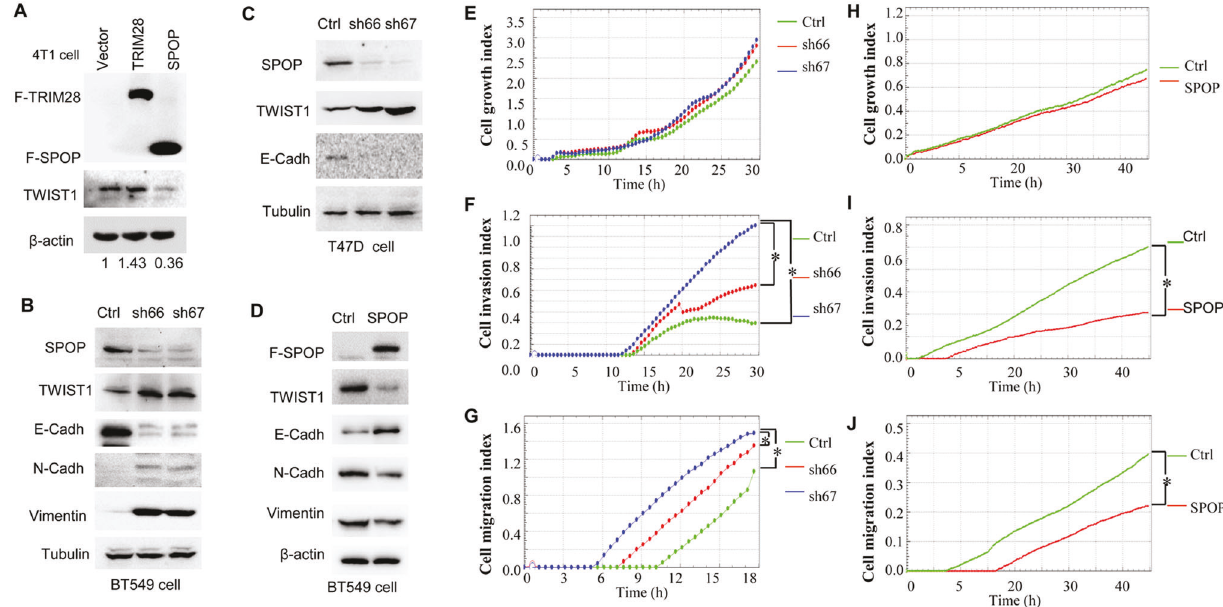
Fig. 2 Knock-down of SPOP up-regulates TWIST1 and promotes breast cancer EMT, cell migration and invasion, whereas up-regulated SPOP suppresses EMT. A Over-expressed SPOP decreases TWIST1 protein levels. B Knock-down of SPOP up-regulates TWIST1 and facilitates expression of epithelial markers N-cadherin and Vimentin, and also downregulates mesenchymal marker E-cadherin in breast cancer cell BT549. Cells transfected with shCtrl or shSPOP (sh66 and sh67) vectors and protein lysates were collected at the indicated times for western blotting. C Knock-down of SPOP up-regulates TWIST1 and down-regulation of mesenchymal marker E-cadherin in breast cancer cell T47D. There is no detectable N-cadherin and Vimentin in T47D. D Over-expressed SPOP decreases TWIST1 protein levels and inhibits epithelial markers N-cadherin and Vimentin, and upregulates mesenchymal marker E-cadherin in breast cancer cell BT549. E – G Roles for cell index, cell migration and invasion by knock-down of SPOP in BT549 cell line. H – J Roles for cell index, cell migration and invasion by overexpression of SPOP in BT549 cell line. Real-time cell growth index, migration and invasion assays were performed in a real time cell analyzerr, p -value ≤ 0.05 was considered as a signi fi cant difference (*). N-cadh, N-cadherin. E-cadh